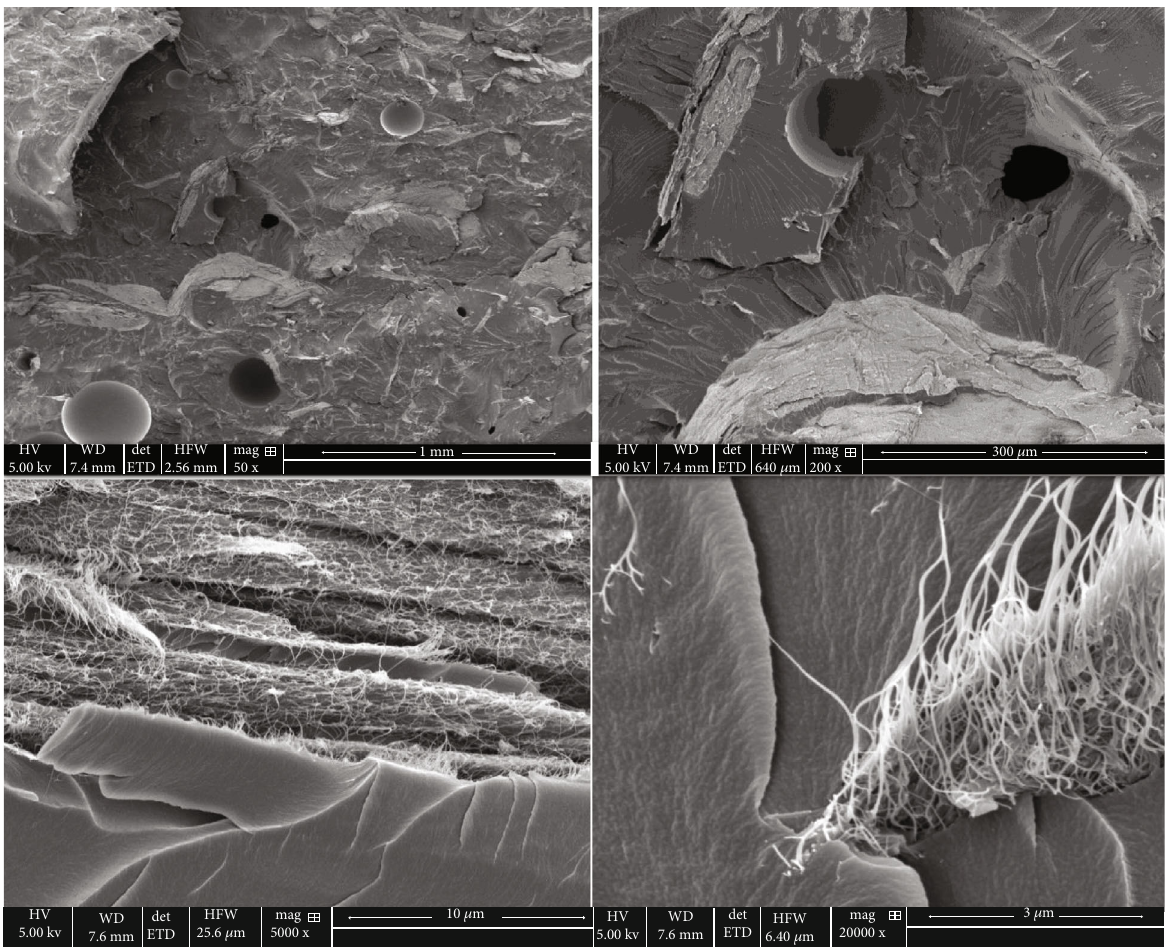
Figure 20: Fracture surfaces in a 1.5 wt.% SWCNT-reinforced epoxy composite subjected to 1500 thermal